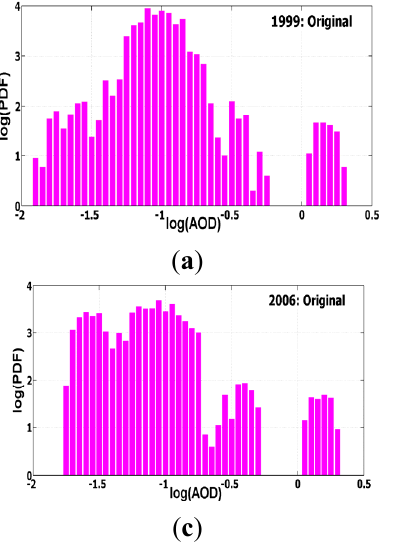
Figure 6. Examples of the (PDFs) of AODs (at 0.5 μ m) retrieved at the ARM NSA site in Barrow, Alaska by the original ( left ) and improved ( right ) cloud-screening algorithms for 1999 ( a , b ), 2006 ( c , d ), and 2008 ( e , f ). These years correspond to those shown in Figure 1. Since the relative contribution of the “bad” points to the total number of points is quite small (<0.5%; Table 1), the log(PDF) is used. Note that the PDFs represent frequencies and they are functions of log(AOD). The PDFs generated by the original algorithms (left) include cloud-contaminated points with large AODs (log(AOD) > 0). The relative fraction of these cloud-contaminated points is 0.32, 0.43 and 0.42% for years 1999, 2006 and